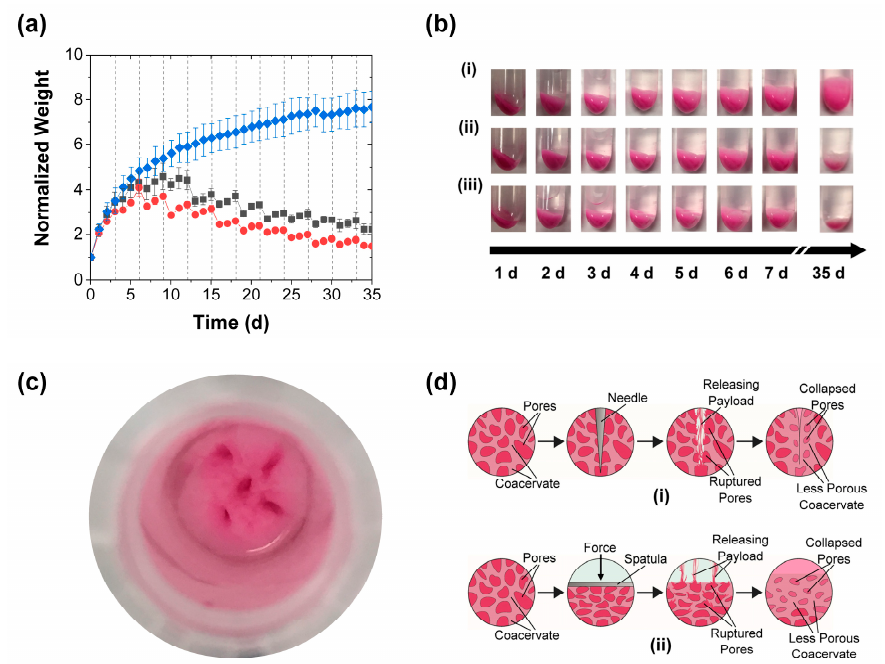
Figure 3. Coacervate swelling during the RhB release into deionized water achieved with ( ■ ) periodic perforation, ( • ) periodic compression, and ( (cid:7) ) without mechanical stimulation and characterized by ( a ) gravimetric analysis of the evolutions in normalized weights (mean ± SD) and ( b ) digital photography (i) without mechanical stimulation, (ii) with periodic perforation, and (iii) periodic compressions. Also shown are ( c ) a top view of a coacervate sample after a perforation treatment and ( d ) schemes of the solvent-filled pores collapsing after each mechanical treatment. The coacervates in this experiment were stimulated every 3 d using either five needle jabs or a spatula. All coacervate weights are normalized to their initial values at the start of the release experiment. The solid lines are guides to the eye, while the dashed vertical lines mark the mechanical stimulation times.